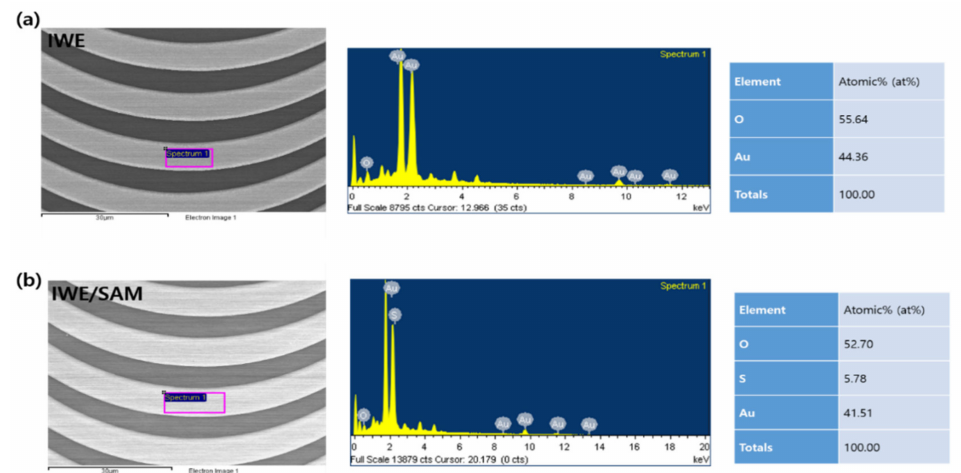
Figure 3. EDS results of ( a ) bare IWE; ( b ) IWE with the modification of SAM on the surface